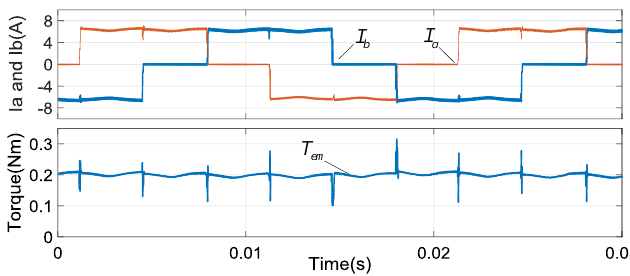
Figure 8. Test waveforms at the speed of 1500r/min with SWC.